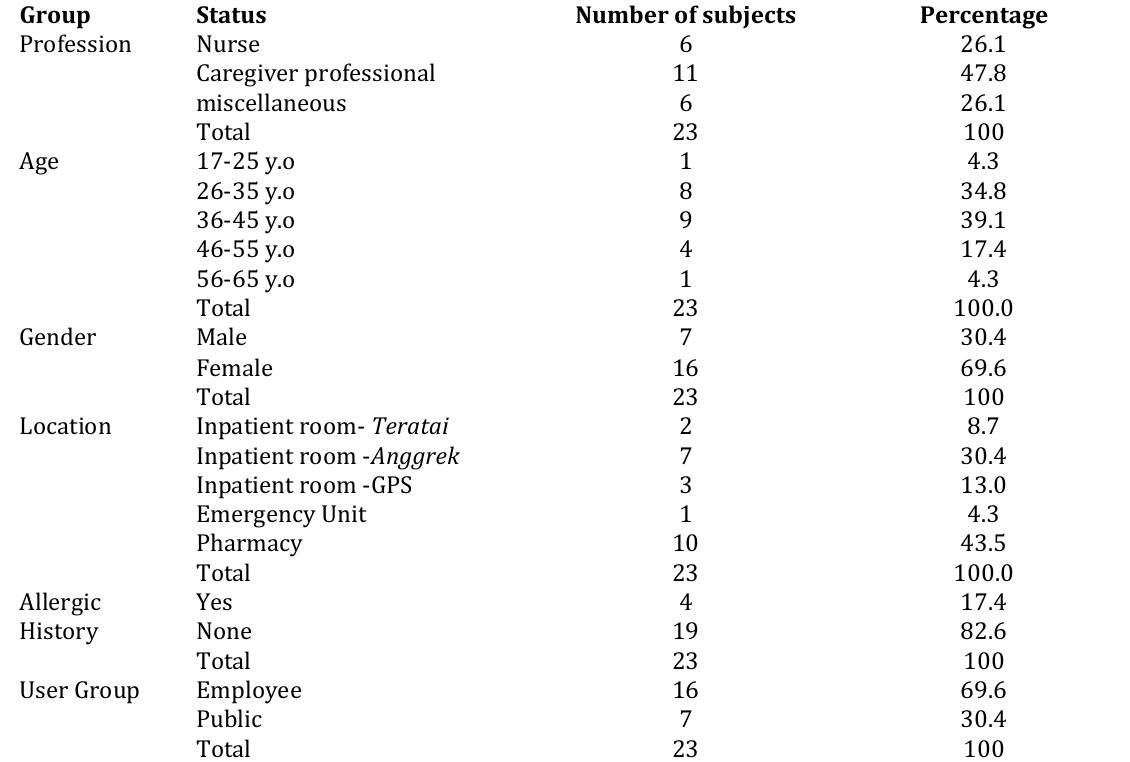
Table VI. Analysis of subject demographic data